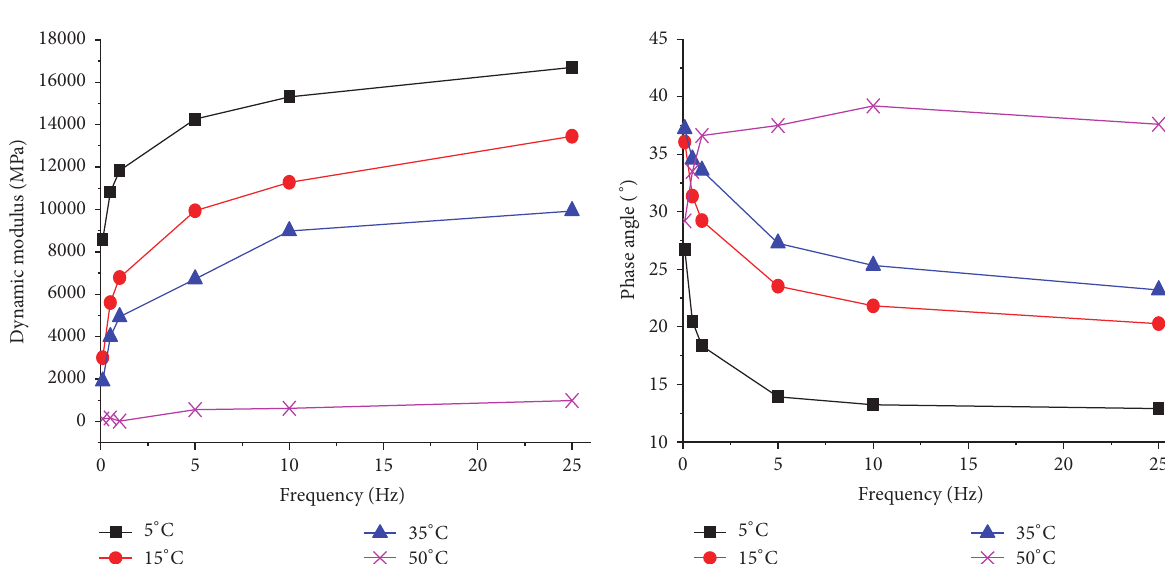
Figure 5: The dynamic modulus and phase angle of SK-90 asphalt